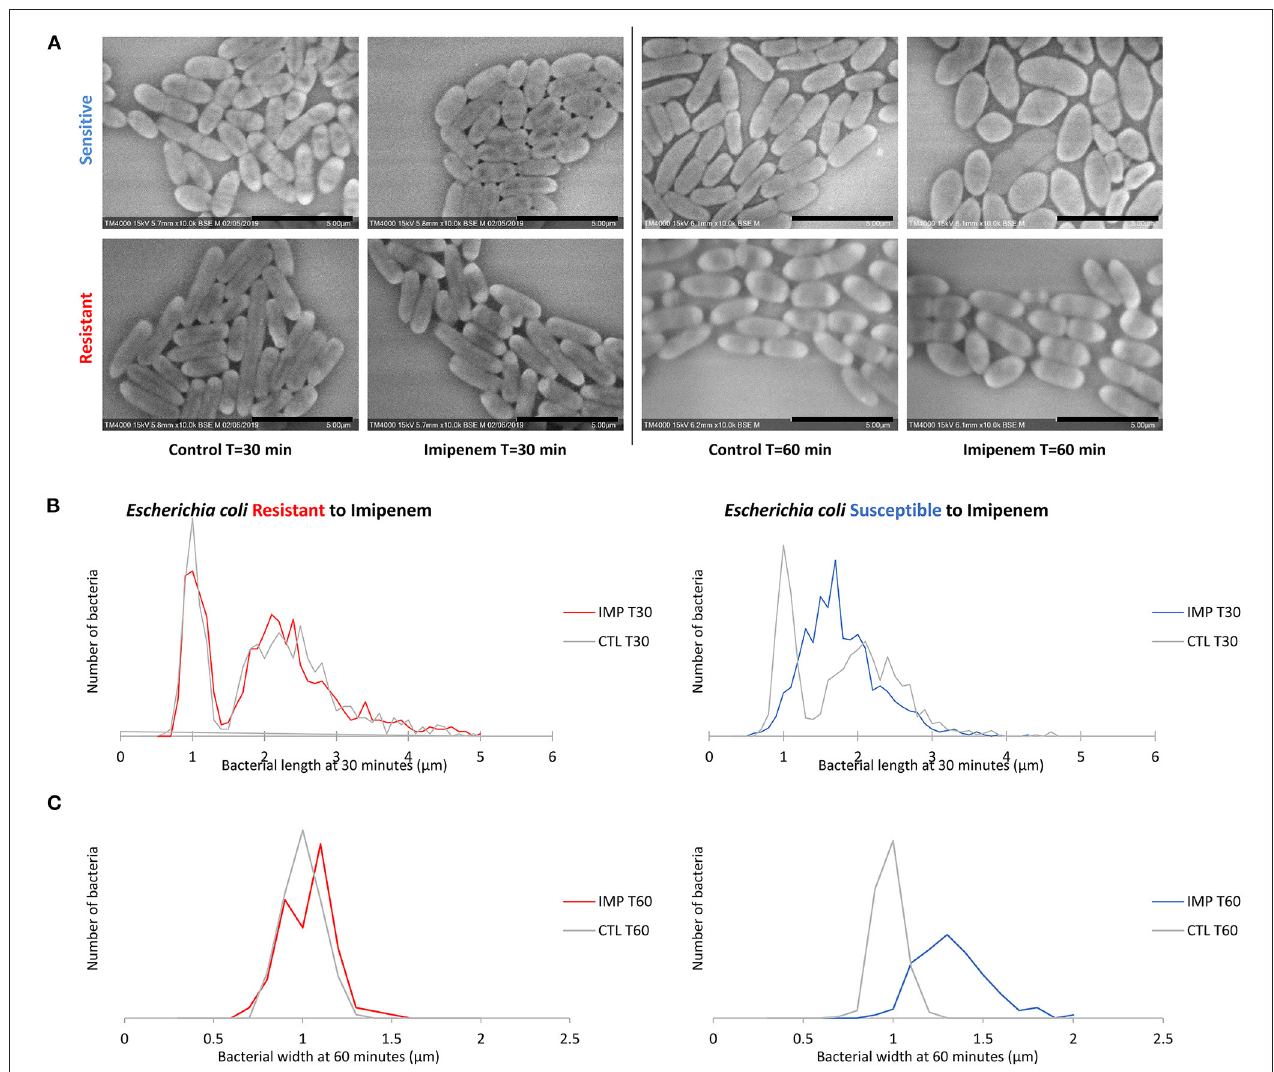
FIGURE 4 | Modifications observed on E. coli incubated with and without IPM for 30 and 60min. (A) Micrographs recorded on TM4000 Plus. Bacterial inflation and damage observed at 60min in the susceptible isolates confirms the susceptibility of that isolate toward IPM. (B) Histograms showing length measurements at 30min of E. coli for both susceptible and resistant isolates. (C) Histograms showing width measurements at 60min of E. coli for both susceptible and resistant isolates. Scale bars: 5 µ